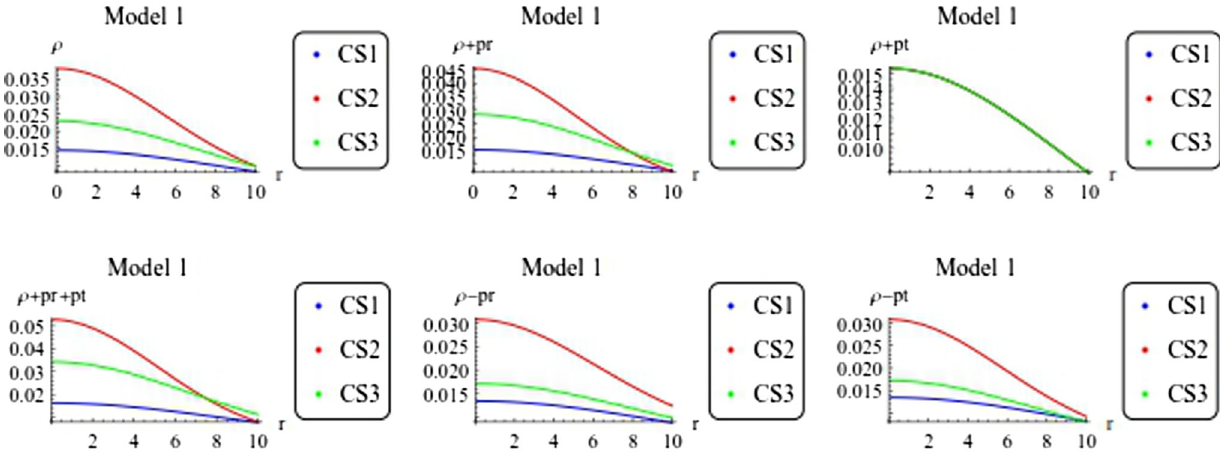
(cid:6) (cid:5) R + (cid:17) ˆ R